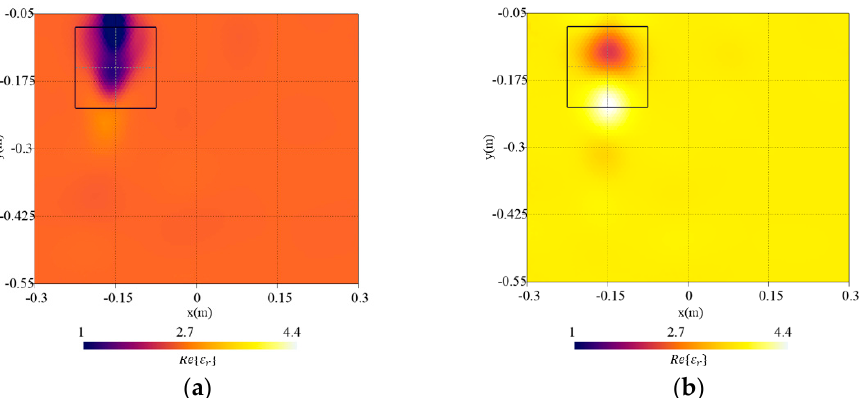
Figure 12. Reconstructed distribution of the real part of the dielectric permittivity, Re { ε r } , in the investigation domain R together with a square box indicating the shape of the actual target. The case of two buried targets with different geometry.